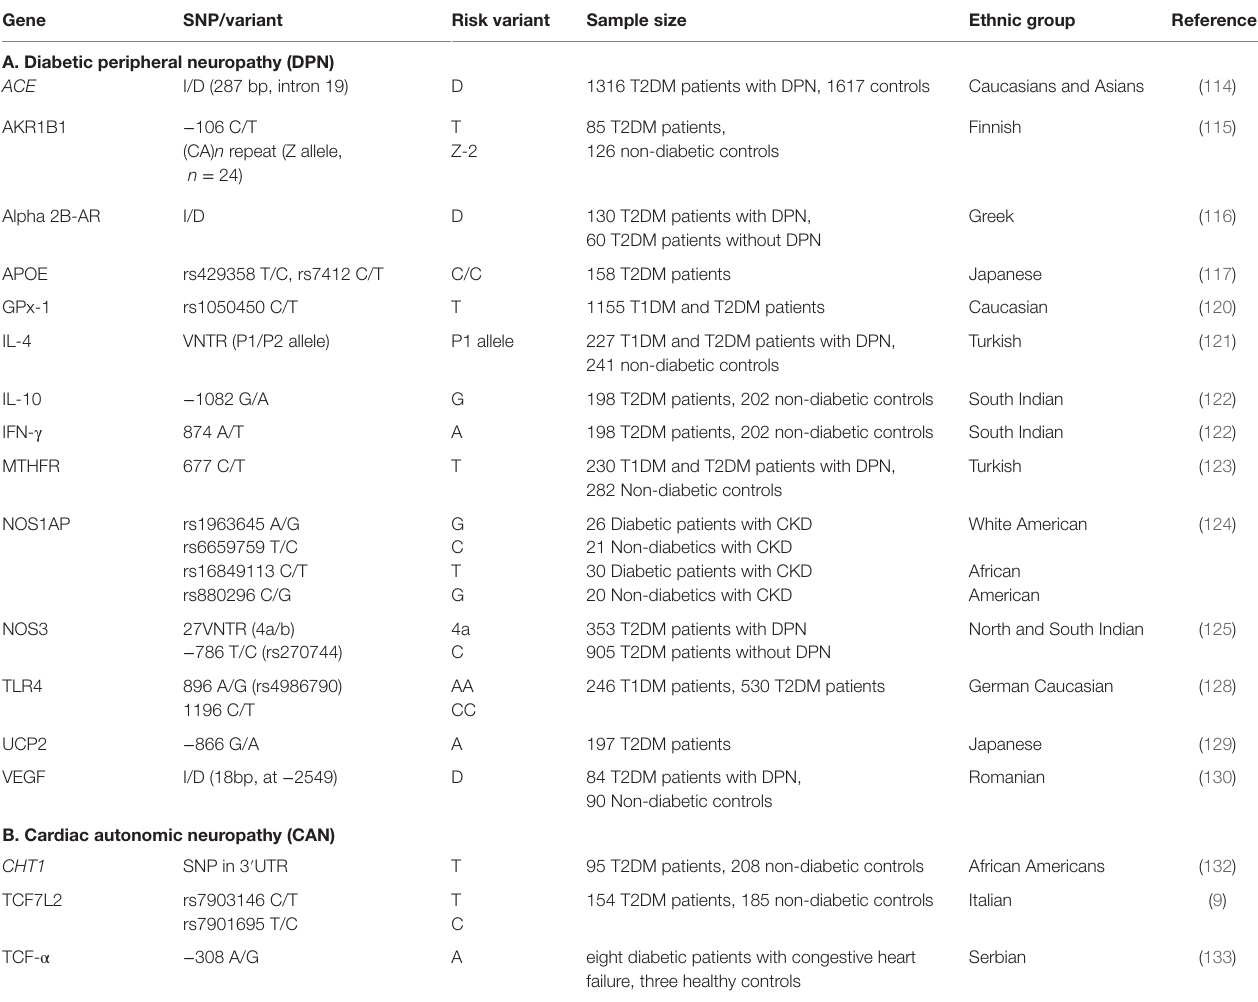
TAble 2 | genetic variants showing a significant association with diabetic neuropathies in